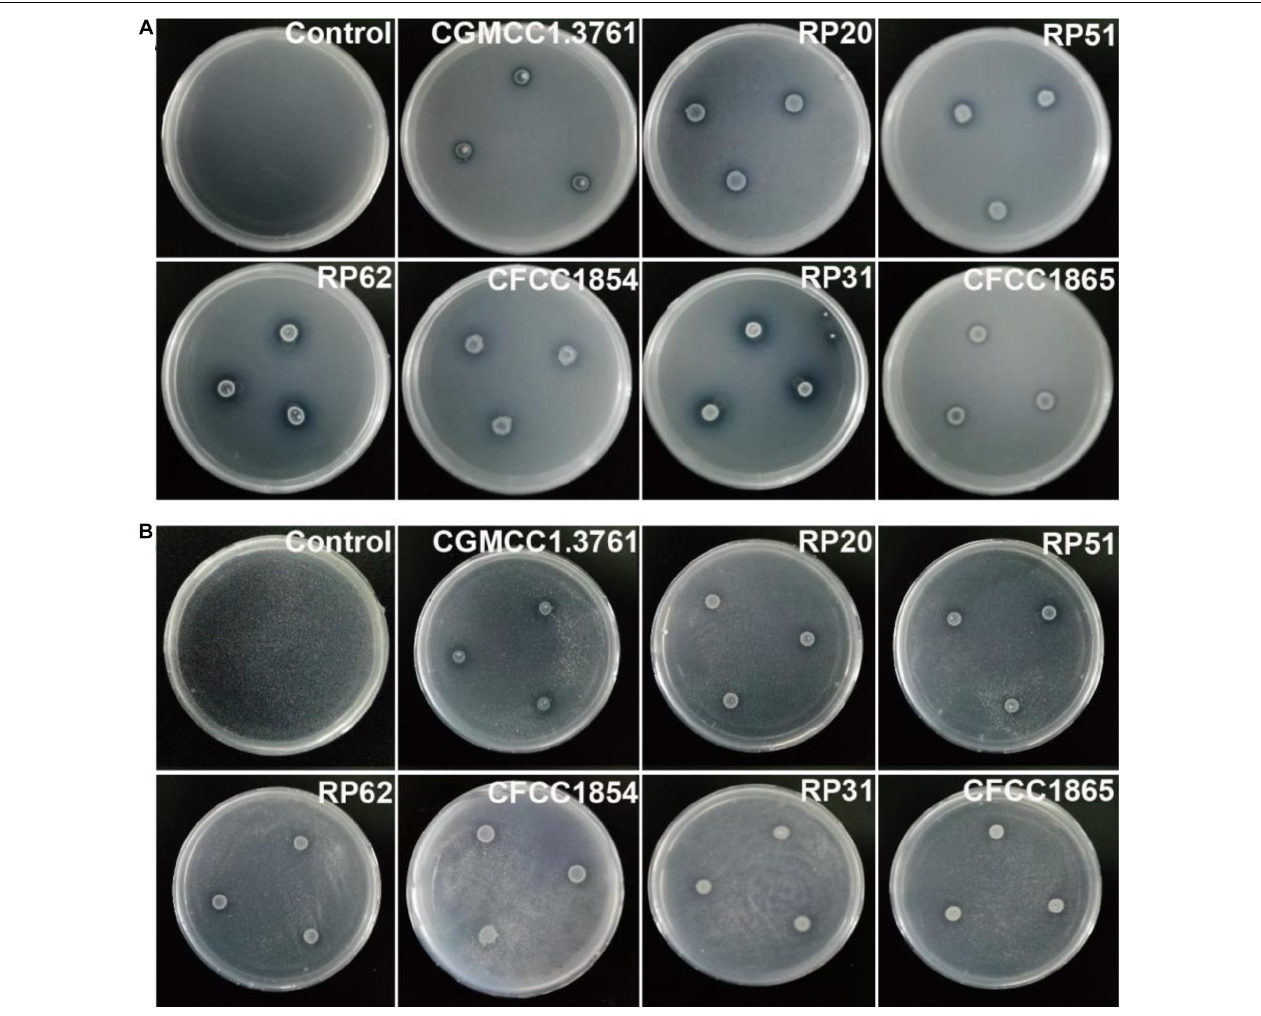
FIGURE 6 | Agar plate assays show solubilization of calcium phosphate (A) and calcium phytate (B) around colonies of P. peoriae CGMCC 1.3761 T and nodule-inhabiting strains within Paenibacillus polymyxa complex.